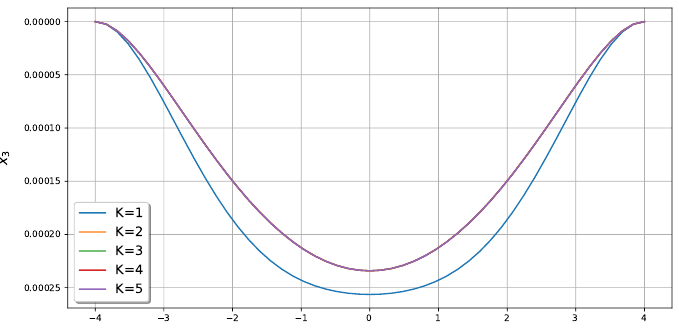
Figure 26. The deflection in section x 2 = 0 of a rectangular plate with clamped edges for different number of approximations.